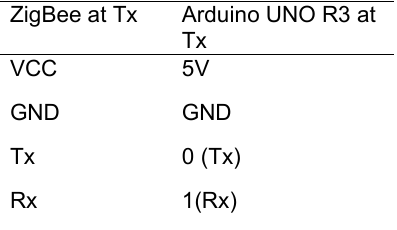
Table 3. Pin connection of ZigBee with Arduino UNO R3 at the transmitting side.